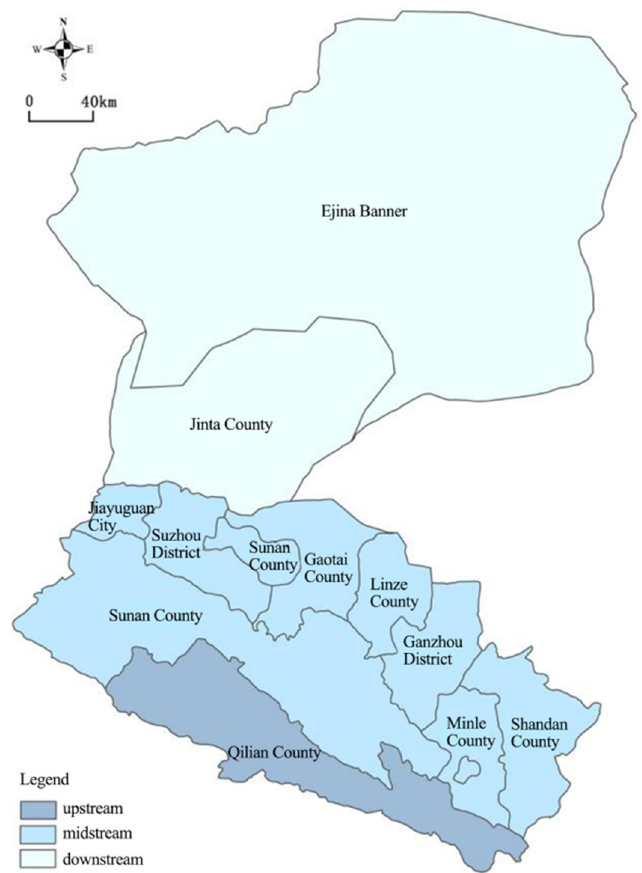
Figure 1. Division of districts and counties in HRB.